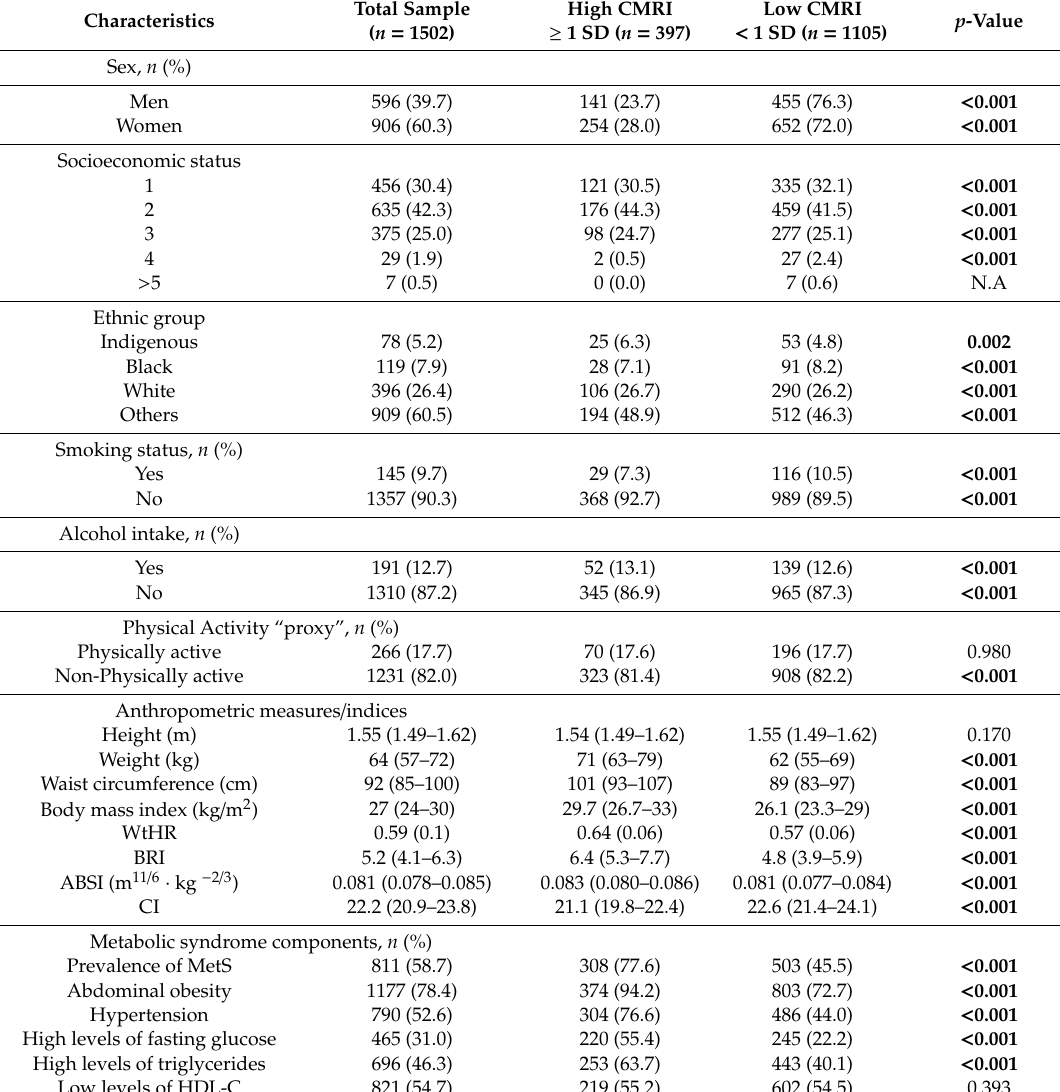
Table1. Characteristicsofstudyparticipantsaccordingtohigh( ≥ 1SD)andlow( < 1SD)cardiometabolic risk index (CMRI) status among Colombian older